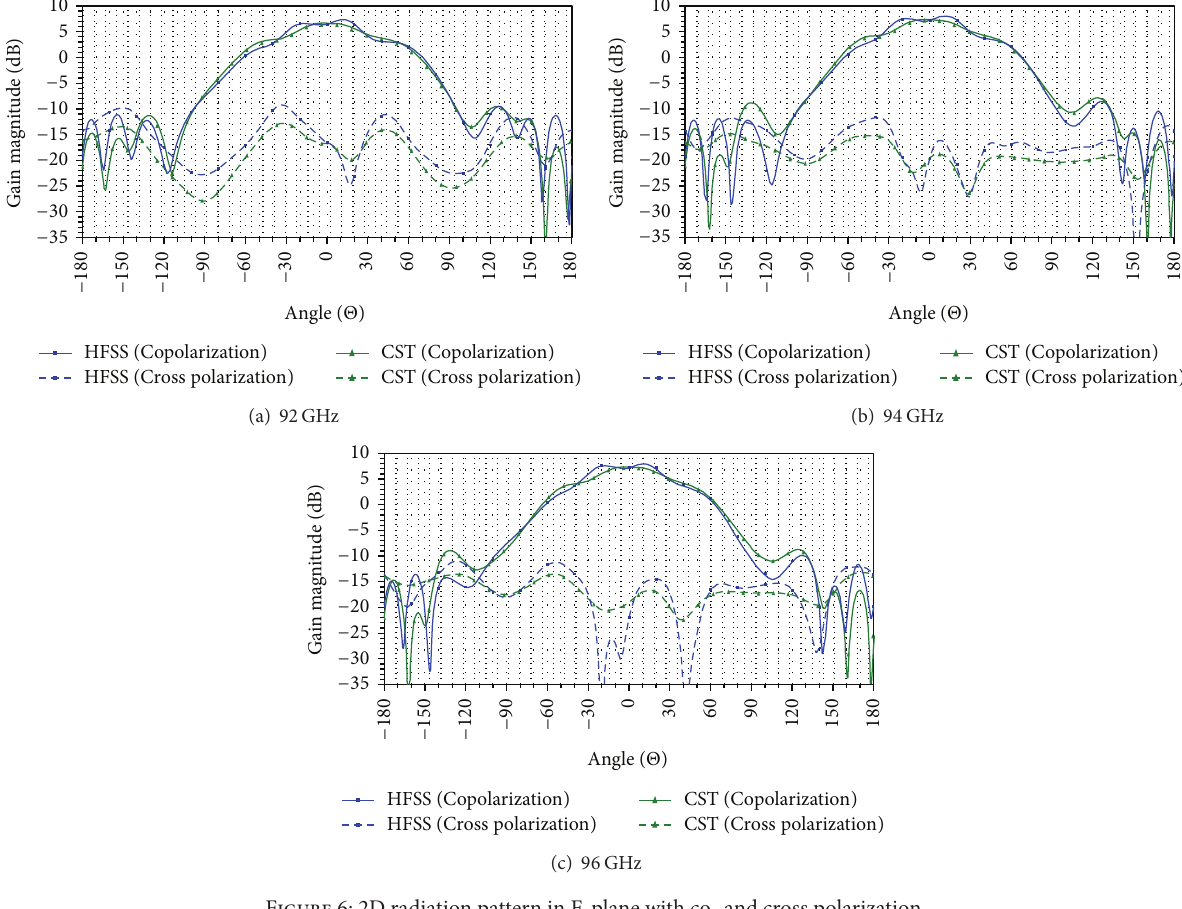
Figure 6: 2D radiation pattern in E-plane with co- and cross polarization.